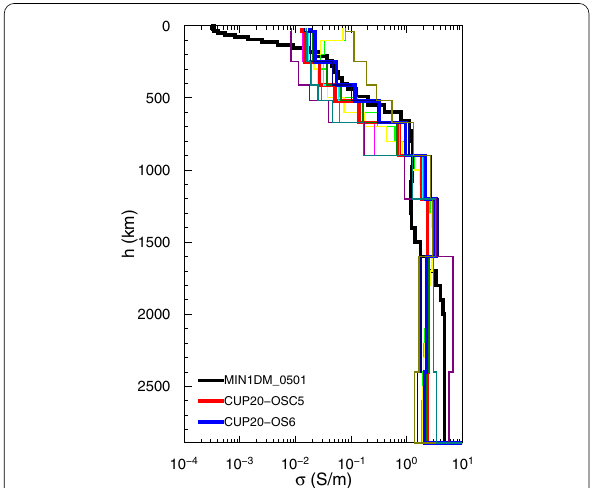
Fig. 4 Spherically symmetric electrical conductivity profiles. Models MIN1DM_0501, CUP20-OSC5, and CUP20-OS6 are shown, respectively, with black, red, and blue thick lines. The spherically symmetric parts of other models obtained by inversions of the remaining datasets in Table 1 are shown by thin lines of various